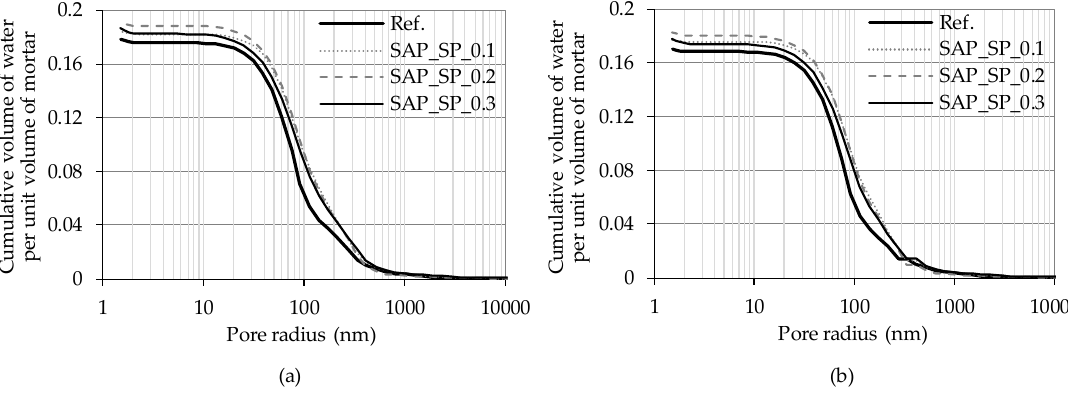
Figure 9. Cumulative volume of water absorbed by a unit volume of mortar. ( a ) Raw MIP data and ( b ) MIP data after modifications were applied in the calculations. Table 6. Calculation procedure for absorbency of SAP_SP during capillary water uptake in mortar. Sample